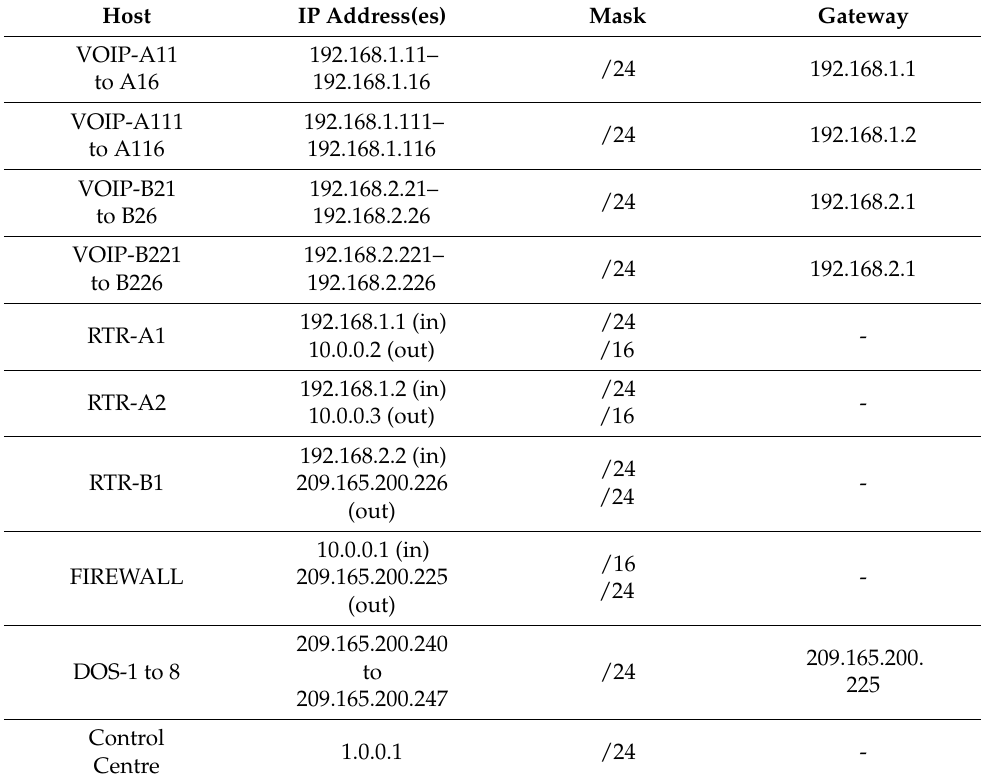
Table 2. IP addressing scheme used in the network